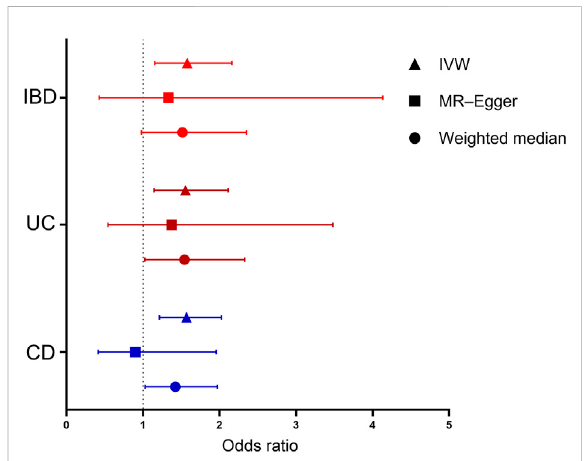
FIGURE 1 Forest plot for the causal effects of in fl ammatory bowel disease (IBD), ulcerative colitis (UC), and Crohn ’ s disease (CD) on IgA nephropathy (IgAN). Each point represents the combined causal estimate using all SNPs together in a single instrument with the IVW (triangle), MR-Egger (square), and weighted median (circle) methods. Horizontal lines represent the 95% con fi dence interval (red: IBD, brown: UC, and blue: CD). (IBD, in fl ammatory bowel disease; UC, ulcerative colitis; CD, Crohn ’ s disease; SNP, single-nucleotide polymorphism; IVW, inverse-variance weighting; MR-Egger, Mendelian randomization –